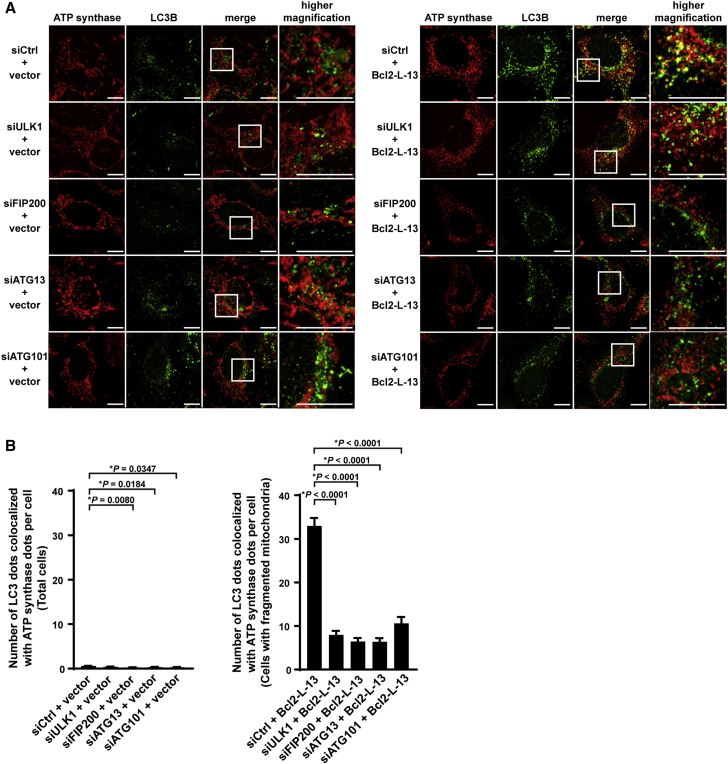
The ULK1 Complex Is Important for Bcl2-L-13-Mediated Mitophagy(A and B) HEK293A cells were transfected by indicated siRNA for 72 hr followed by transfection of empty vector or HA-Bcl2-L-13. Forty-two hours after transfection, cells were treated with 100 nM bafilomycin A1 for 6 hr and immunostained with anti-LC3B and anti-ATP synthase antibodies. Images in the box at higher magnification are shown on the right. Representative fluorescent images are shown in (A) and the number of LC3B dots colocalized with ATP synthase dots per cell is shown in (B). At least 20 cells were counted for each group (n = 3). Scale bar: 10 μm. ∗p < 0.05. Results are shown as mean ± SEM.See also Figure S4.